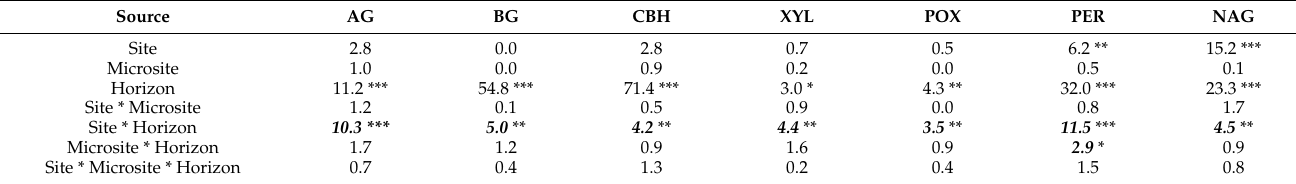
Table 4. Results (F-values and significance) of three-way ANOVA testing effects of site (natural vs. drained wetland), microsite (high vs. low from each site), and soil horizon on extracellular enzyme activity per unit mass of MBC ( µ mol g MBC − 1 h − 1 ) measured in soils from organic and mineral soil horizons. Bold and italicized values represent the highest level significant main effect or interaction, upon which further interpretation was based.